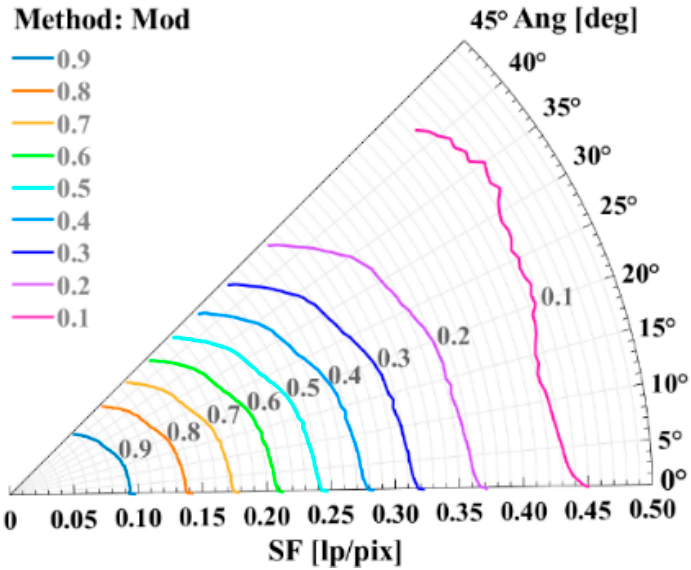
Figure 18. MTF for different tilt angle BDE images vary from 0.20 deg to 44.5 deg (the angle interval is 0.50 deg) in polar coordinates using Mod edge method.